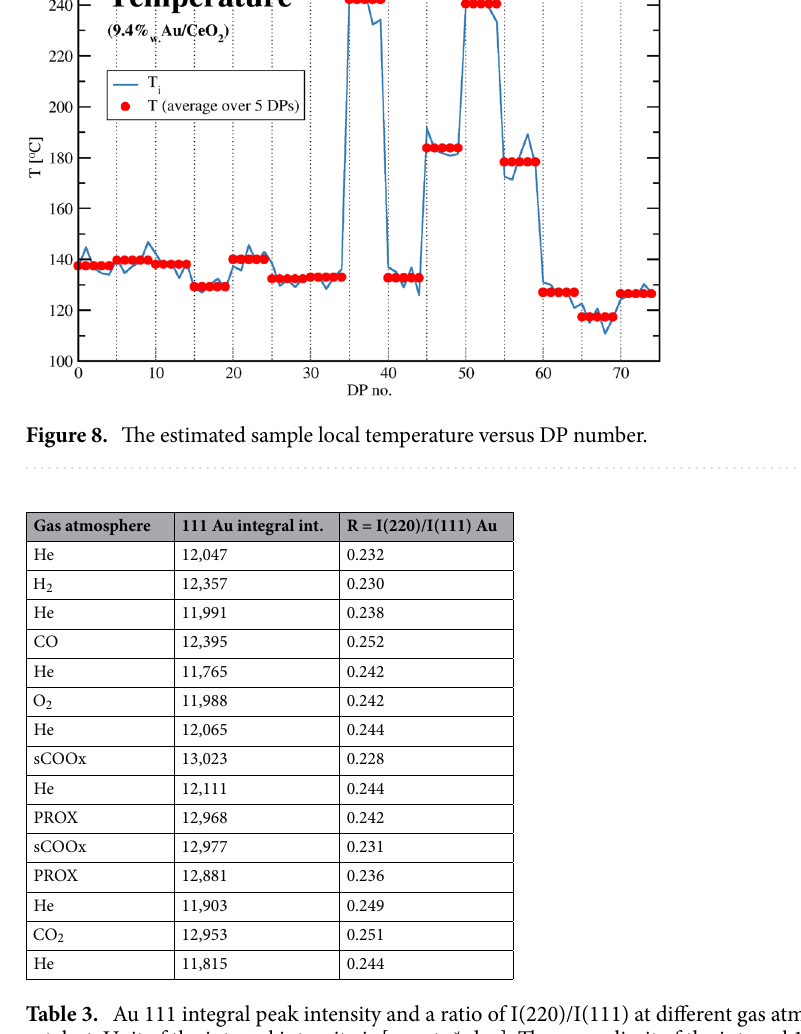
Table 3. Au 111 integral peak intensity and a ratio of I(220)/I(111) at different gas atmospheres for Au/CeO 2 catalyst. Unit of the integral intensity is [counts * deg]. The upper limit of the integral 111 peak intensity error is estimated as 20, the error of the ratio as less than 0.0015.